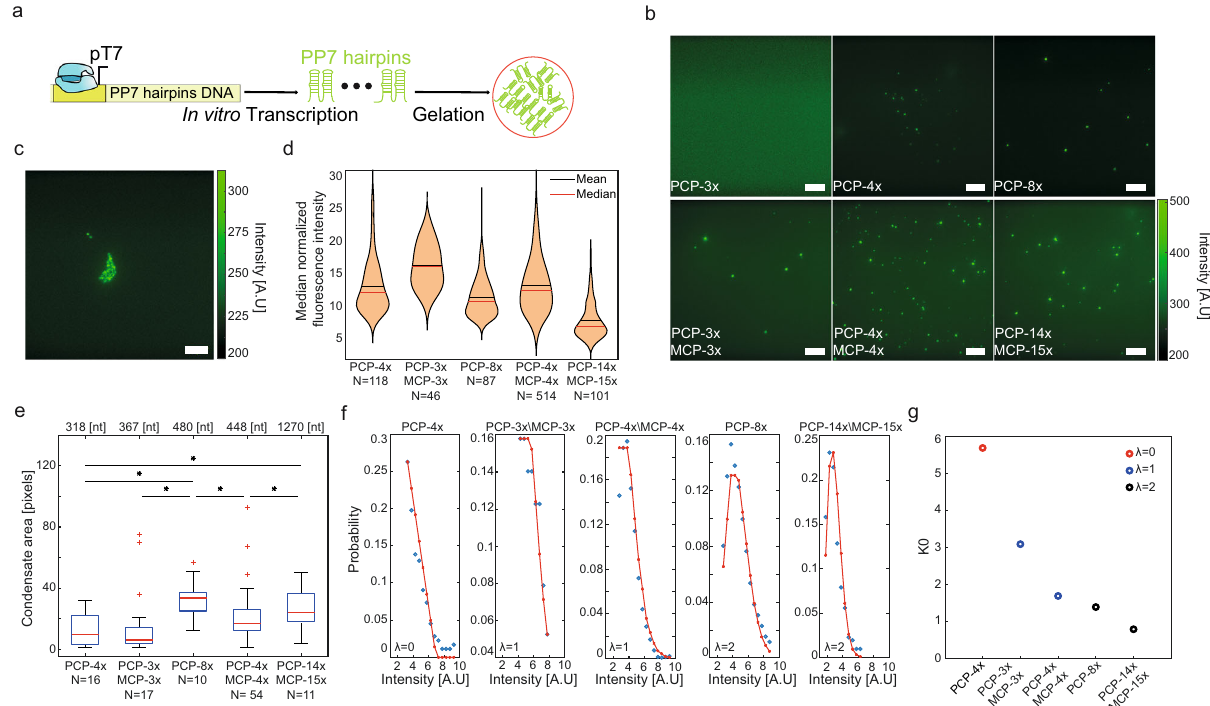
Fig. 1 | Hairpin-containing slncRNA molecules phase separates in vitro. a Constructdiagram depicting invitrotranscription ofhairpincontaining slncRNA molecules used and theirgelation undersuitable conditions. b Microscopyimages showing dependence of structure morphology on the number of binding sites in the slncRNA. PP7-3x results in no visible puncta, while other slncRNAs shows multiple isolated puncta and additionallarger fl uorescent structures. Allscalebars are10 µ m. c SampleimageofaPCP-8xgranulereactiondepictingalargerstructure. Scale bar is 10 µ m. d Violin plots of median condensate fl uorescence of slncRNA- only condensates. e Boxplots showing area (in pixels) of localized condensates, showing that longer slncRNA molecules typically result in larger condensates. Asterisks denote statistical signi fi cance at the 5% level according to a two-sample t